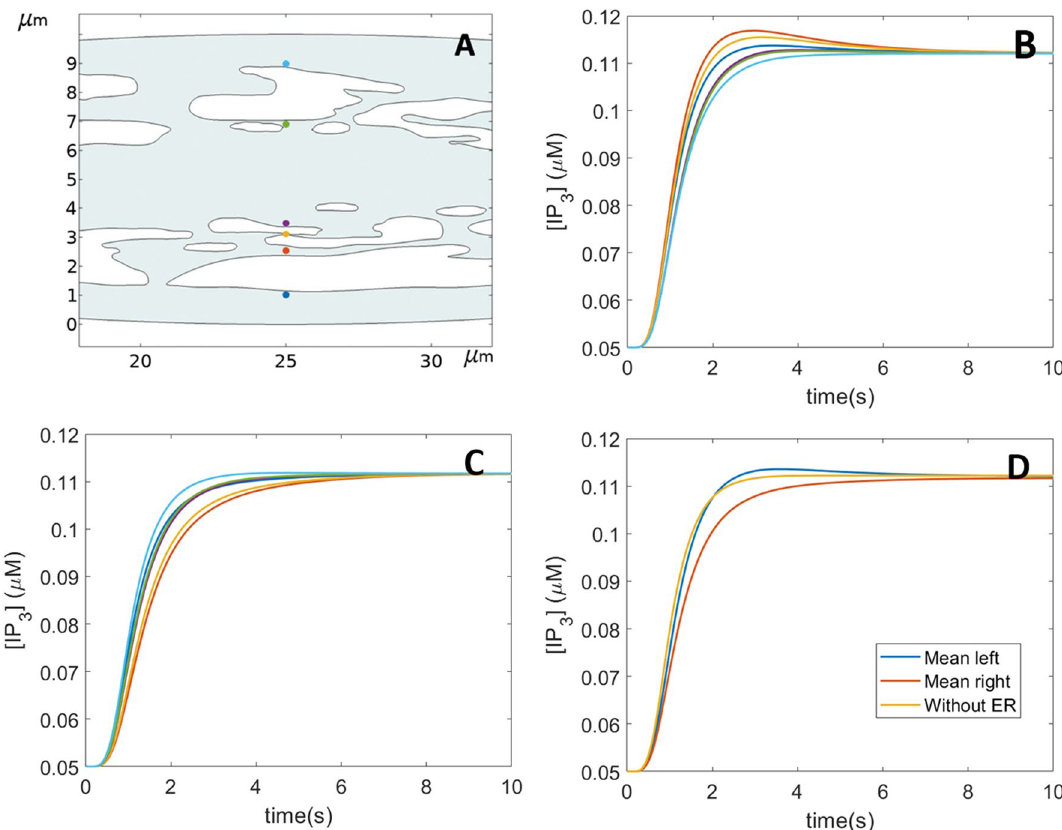
Figure 9. Theoretical investigation of the influence of the ER membranes on the diffusion of IP 3 in a 2D ellipse- shaped cell (50 × 10 μm 2 ). Panel ( A) shows the central part of the simulated cell together with the locations of the clusters considered. Panels ( B and C) show the IP 3 temporal profiles at the different cluster locations considering a spot of photorelease of IP 3 located at the left (B) or at the right (C) extremity of the cell. Line colors correspond to the points in panel A. In panel ( D) , the profiles of the IP 3 concentrations averaged over the six cluster sites are shown for the two situations corresponding to B and C. Simulation procedures are the same as for Fig. 4. The rate of localized IP 3 photorelease, θ, is taken equal to 179.42 μMs −1 , which corresponds to the 250 μMs −1 used in the other simulations with the volumetric